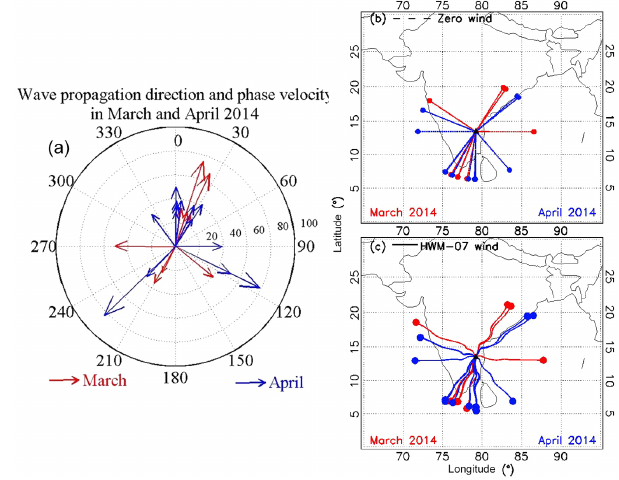
Figure 9. As in Fig. 5 but for the year 2013.